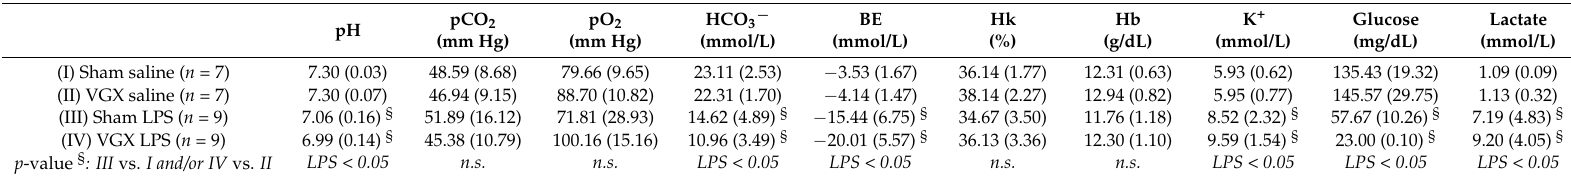
Table 1. Intraoperative blood gas analysis at the end of the